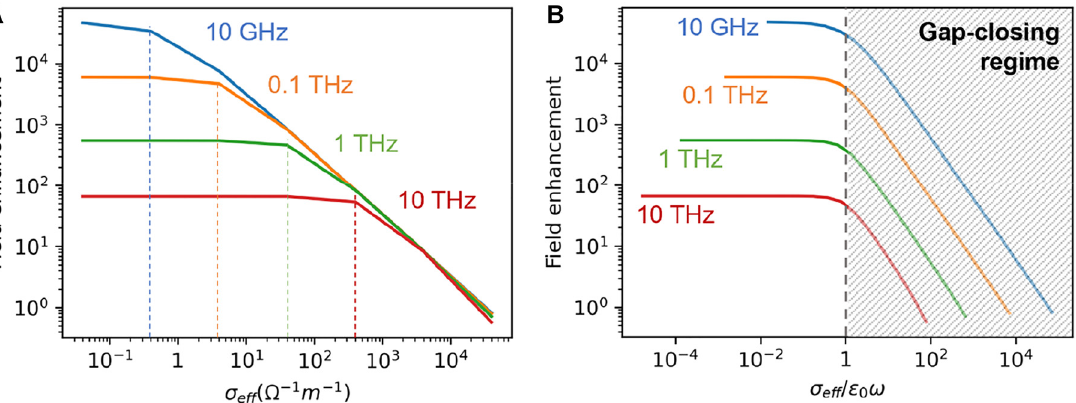
Figure 9: (A) Field enhancement factors of an infinite slit array with 1 nm gap width and 50 μ m period, fi lled with effective conductivity σ eff . De fl ection points appear at different valuesof σ eff for different frequencies. (B) Field enhancement factor as a function of σ eff / ε 0 ω for different frequencies, showing universal transition behavior at σ eff / ε 0 ω ≃